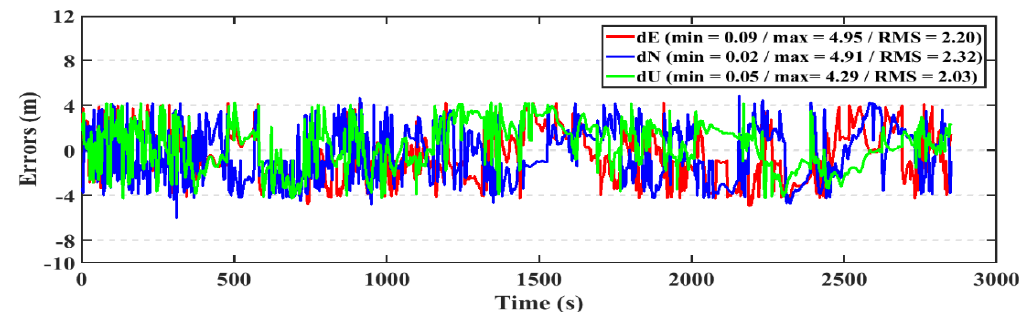
Figure 20. Position errors for the post-processed PPP solution (kinematic/first dataset).